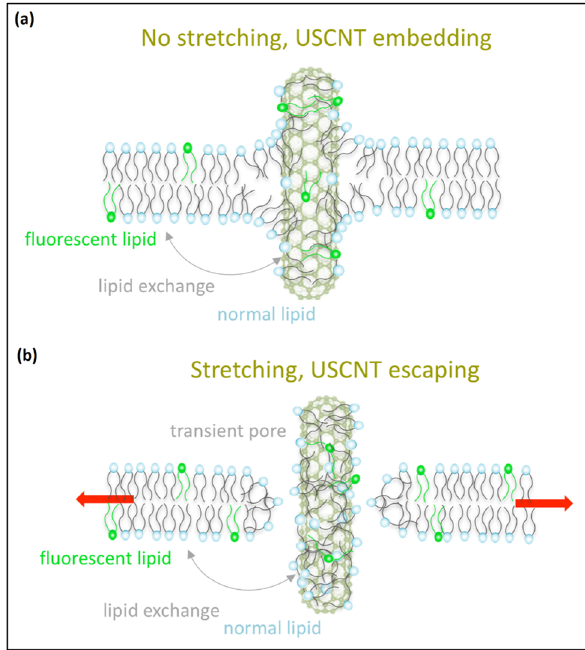
Figure 19: Suggested penetration mechanism of hydrophobic ultrashort CNT ( USCNT ) by rupturing the lipid bilayer of the cell wall. ( a ) Dioleoylphosphatidyl - choline ( DOPC )- capped USCNT interacts